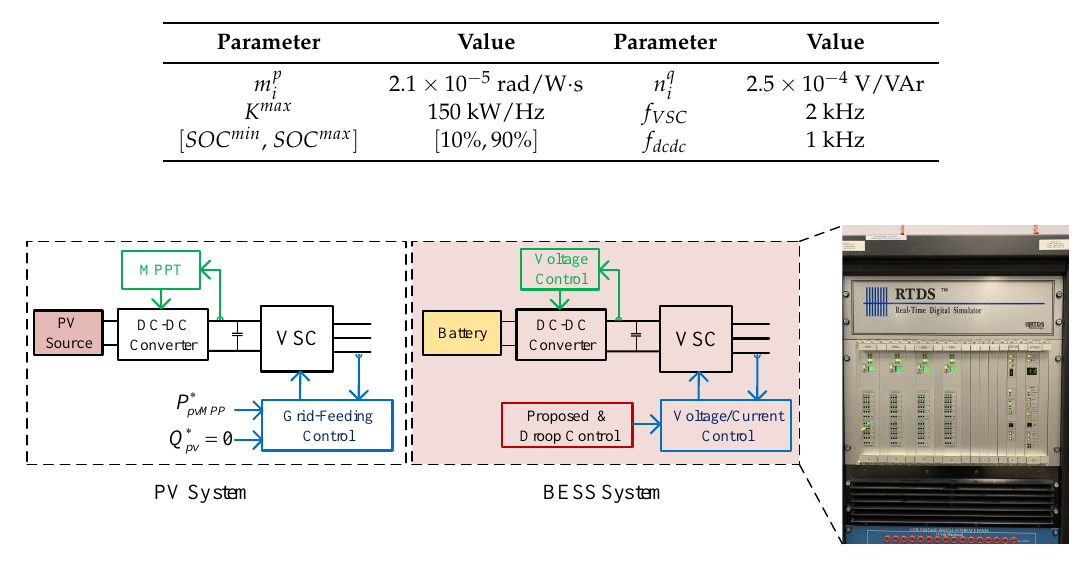
Figure 8. RTDS setup for verification of the proposed decentralized frequency control strategy on an isolated microgrid. Racks 1 implements the isolated microgrid, control systems for both BESSs and PV sources as well as the proposed control system.